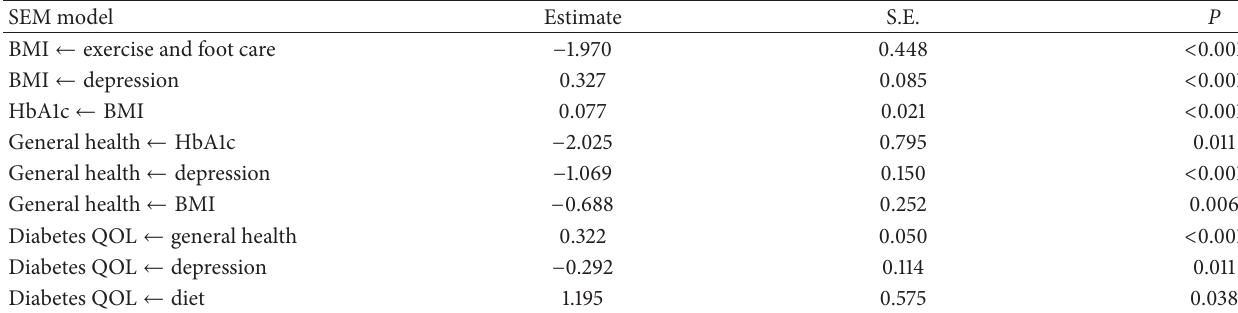
Table 3: Estimated unstandardized regression coefficients in the SEM.